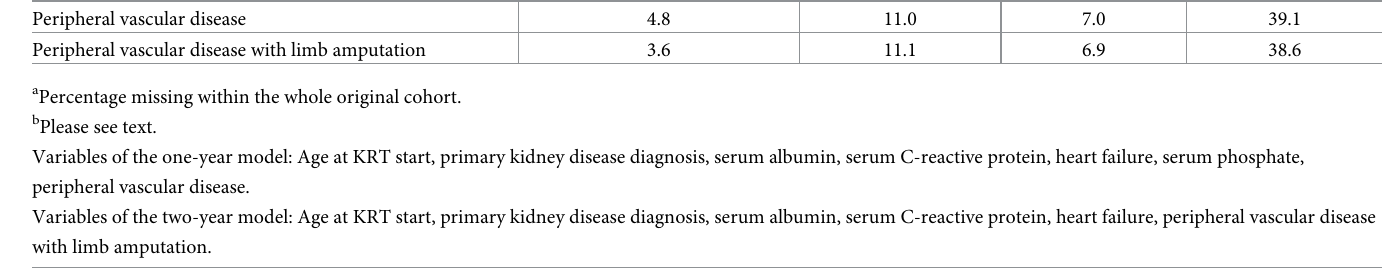
Table 1. Percentage of missing original data (prior to multiple imputation) with respect to the prediction models’ variables, and according to data set. Variable Finnish validation set Age at KRT start 0.0 0.3 0.0 0.0 ESKD diagnosis 0.0 0.0 1.5 Serum albumin 4.9 Serum phosphate 2.9 Serum C-reactive protein 9.1 Heart failure 5.5 Peripheral vascular disease 4.8 Peripheral vascular disease with limb amputation